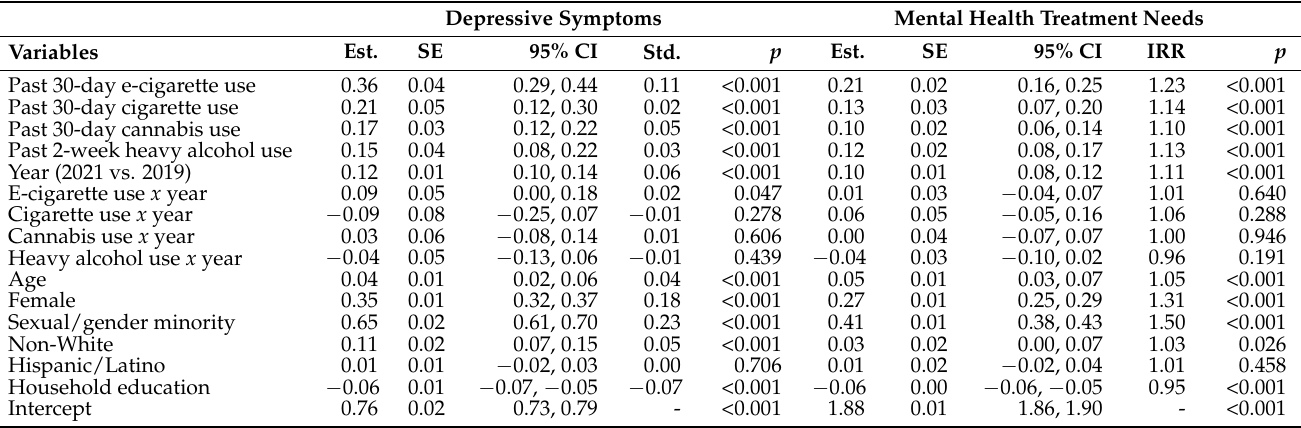
Table 3. Results of pooled, cross-sectional regression models for substance use and sociodemographic factors associated with depressive symptoms and mental health treatment needs for 2019 and